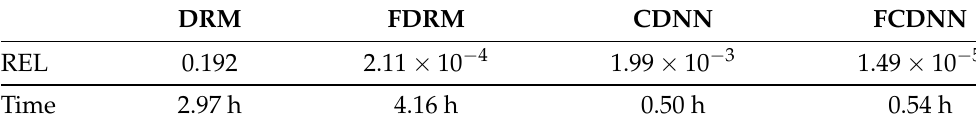
Table 3. REL and running time of the aforementioned four models for Example